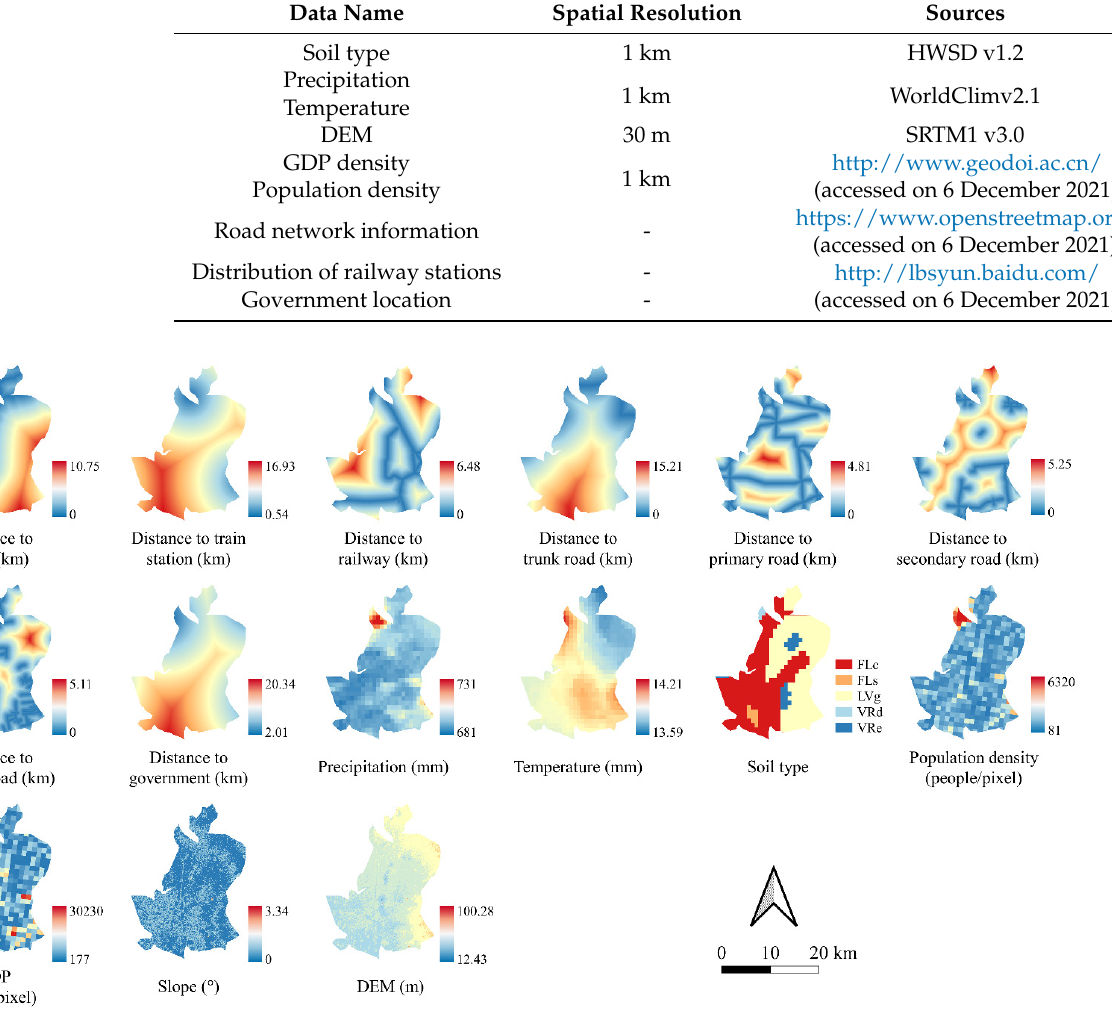
Figure 2. Spatial data for land use modeling.